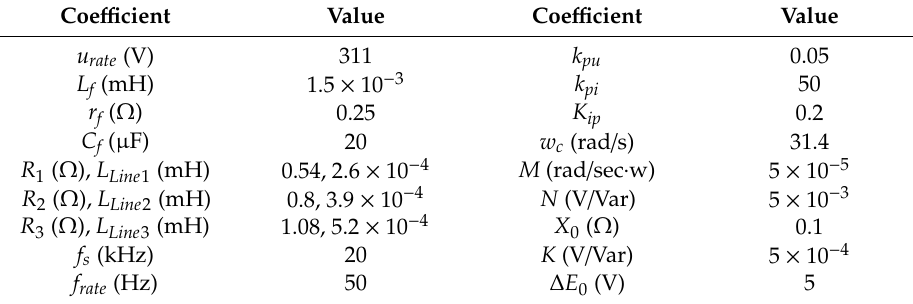
Table 1. The circuit and control parameters of the DG